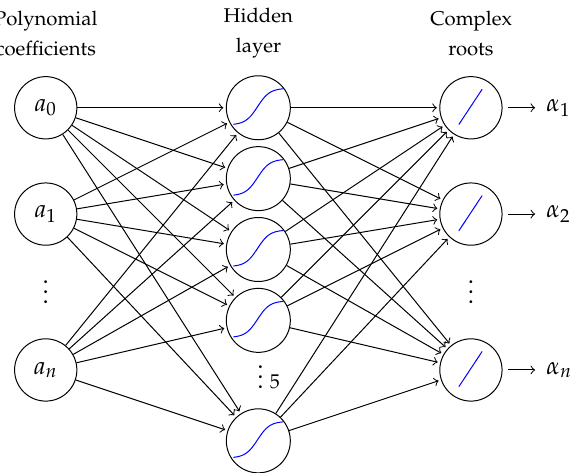
Figure 2. Architecture of the ANN n for root-finding, consisting of ( n + 1 ) input nodes, ten hidden nodes and n output